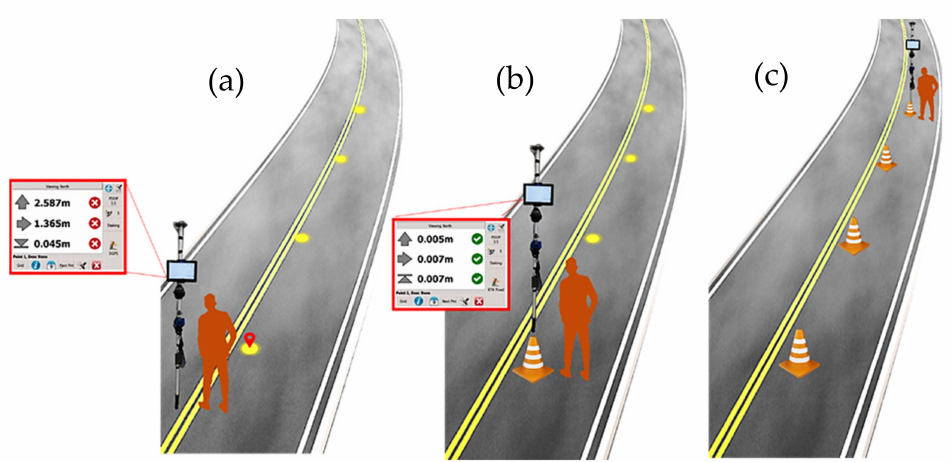
Figure 5. Example of use of the geolocation device: during searching for a given point ( a ), and when this last is reached ( b ); positioning of the road cones in the selected configuration ( c